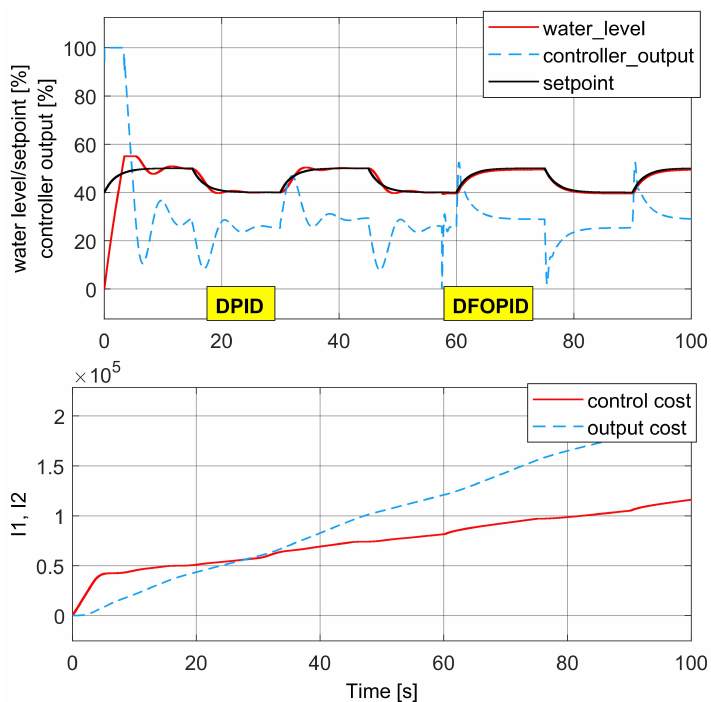
Figure 9. Comparison of the DFOPID and DPID (with optimized parameters) control system implementations on the Simulink